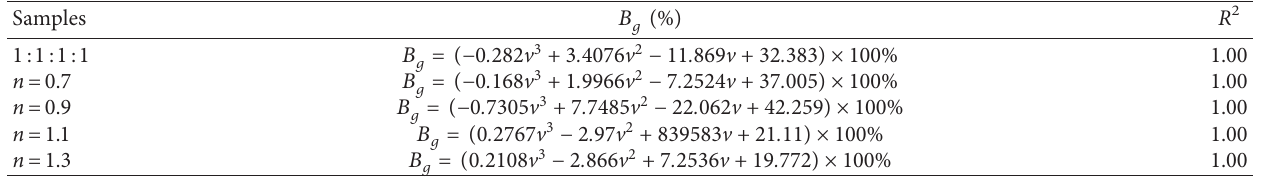
Table 5: The content change of particles with different sizes and the corresponding particle breakage under different loading modes. Samples